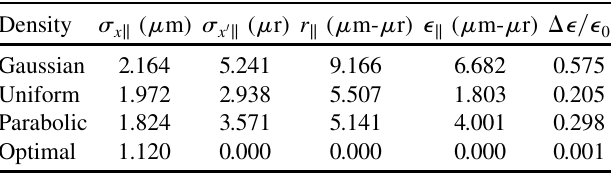
TABLE IV. Relative CSR-induced emittance growth at the end of the final drift of the Berlin-Zeuthen benchmark chicane, assuming a matched initial rms bunch length of 200 (cid:11) m .